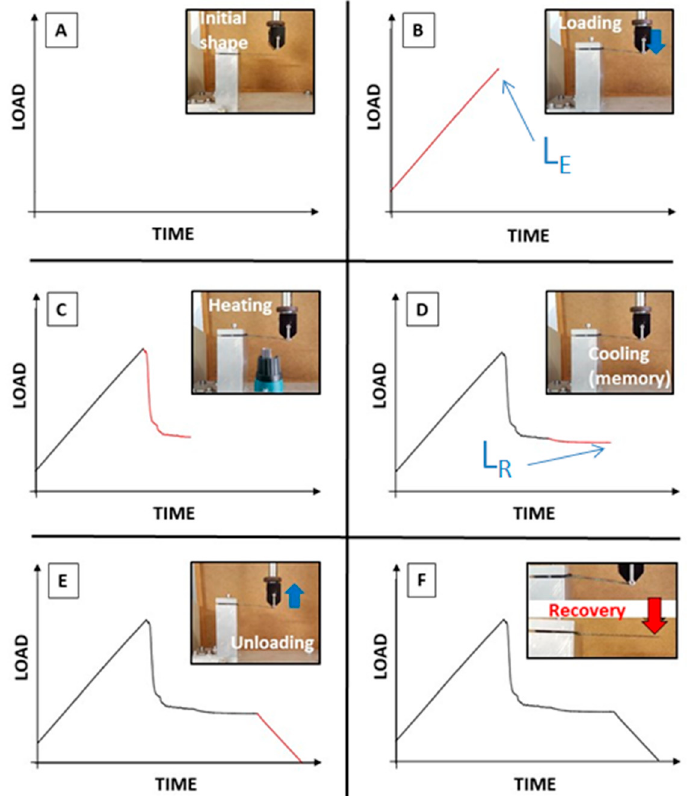
Figure 5. Instrumented thermo-mechanical cycle for SMPC testing. ( A ) equilibrium condition; ( B ) deformation under bending at room temperature; ( C ) heating stage; ( D ) cooling stage; ( E ) unloading; ( F ) free recovery upon heating.